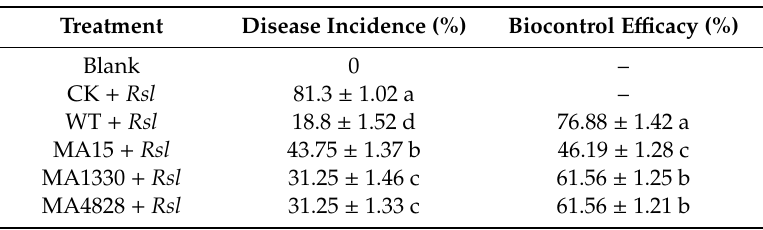
Table 3. Biocontrol efficacy of WT B. pumilus HR10 and biofilm-deficient mutants against pine seedlings damping-off disease caused by R. solani under greenhouse condition. Different letters within a column indicate significant differences ( p < 0.05). There are 16 seedlings per treatment.